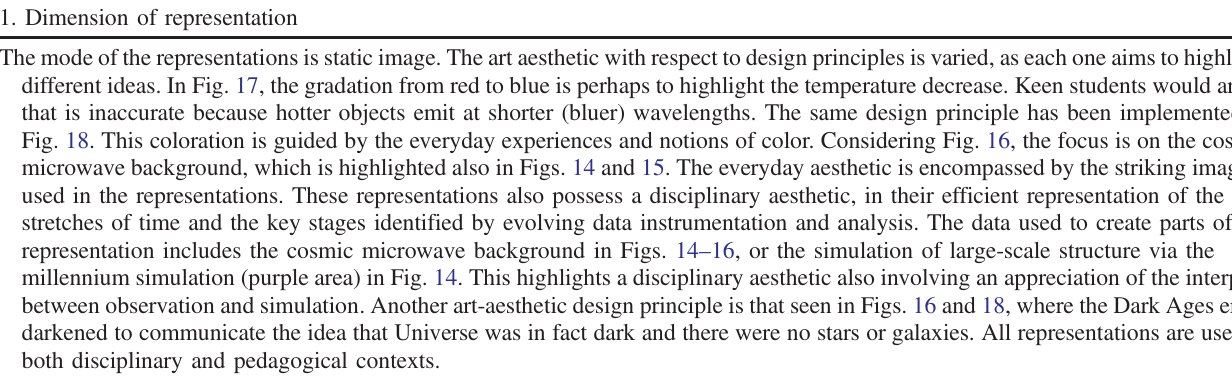
TABLE IV. Unpacking the representations of the timeline of the Universe variations (Figs. 14 – 18). 1. Dimension of representation